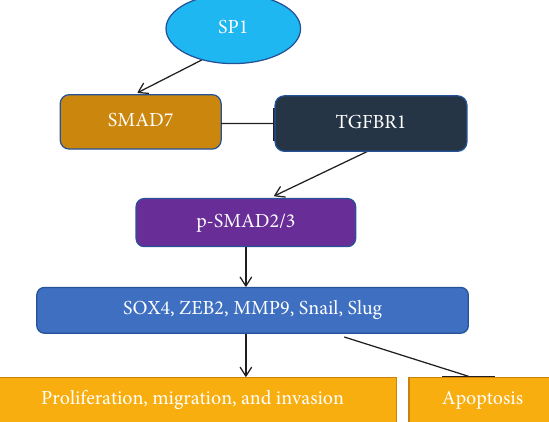
Figure 8: The effects of SP1 regulating TGF- β /SMAD signaling on gastric cancer cell proliferation, apoptosis, migration, and